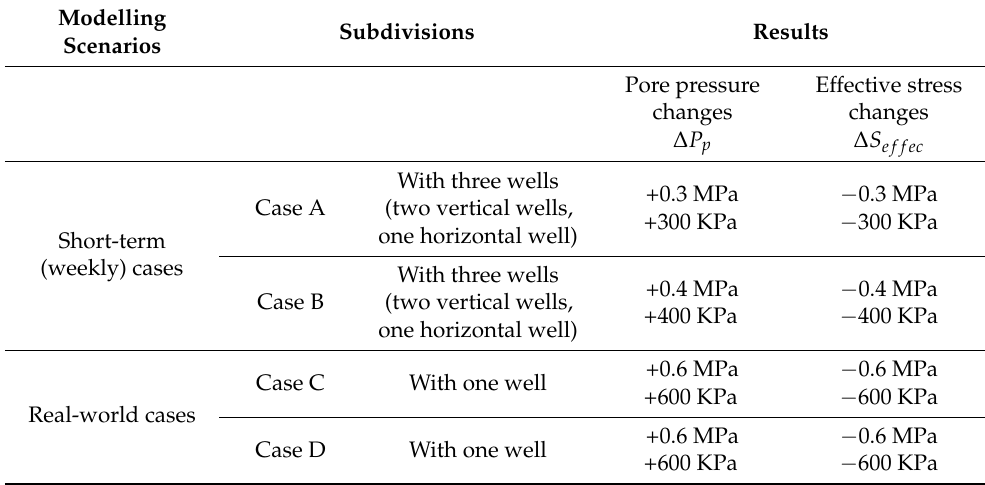
Table 2. Summary of results for all future test scenarios. The sign + in the pore pressure changes indicates a positive change or an increase in pore pressure from time step t1 to t2, while the sign—in the changes in effective stresses denotes a decrease in magnitudes of effective stresses for time step t1 to t2. These two quantities are inversely proportional to each other and are expressed in MPa and KPa for a better understanding of the